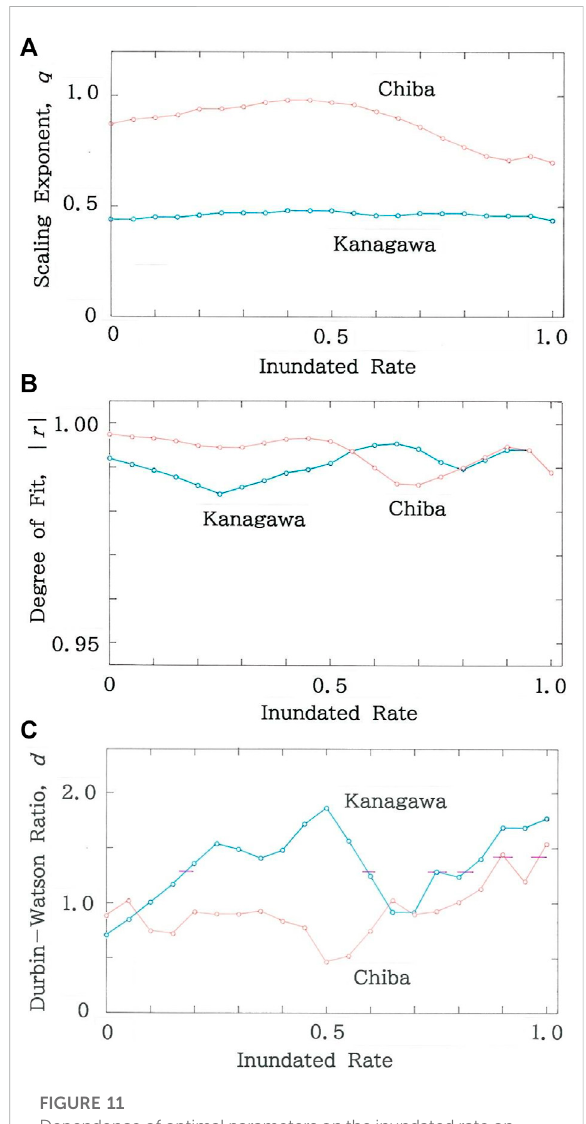
FIGURE 11 Dependence of optimal parameters on the inundated rate on the supposition that effects due to global warming will get more and more inevitable in the future. (A) Scaling exponent. (B) Degree of fi t. (C) Durbin-Watson ratio. The horizontal bar shows d = d U